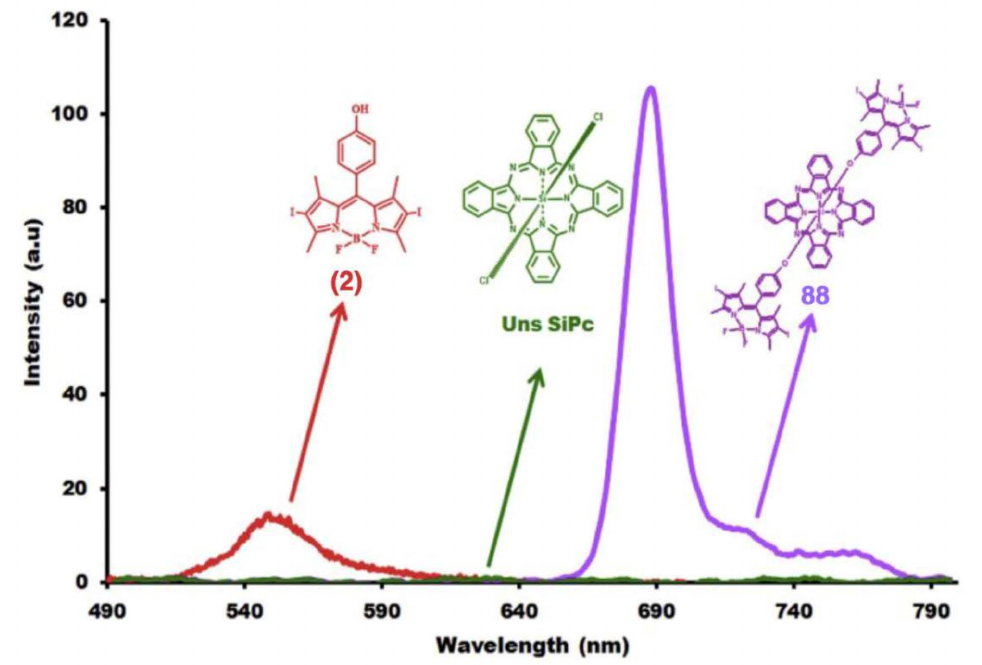
Figure 16. Emission spectra of compounds (2), 88 and unsubstituted silicon(IV) phthalocyanine in toluene. Adapted from